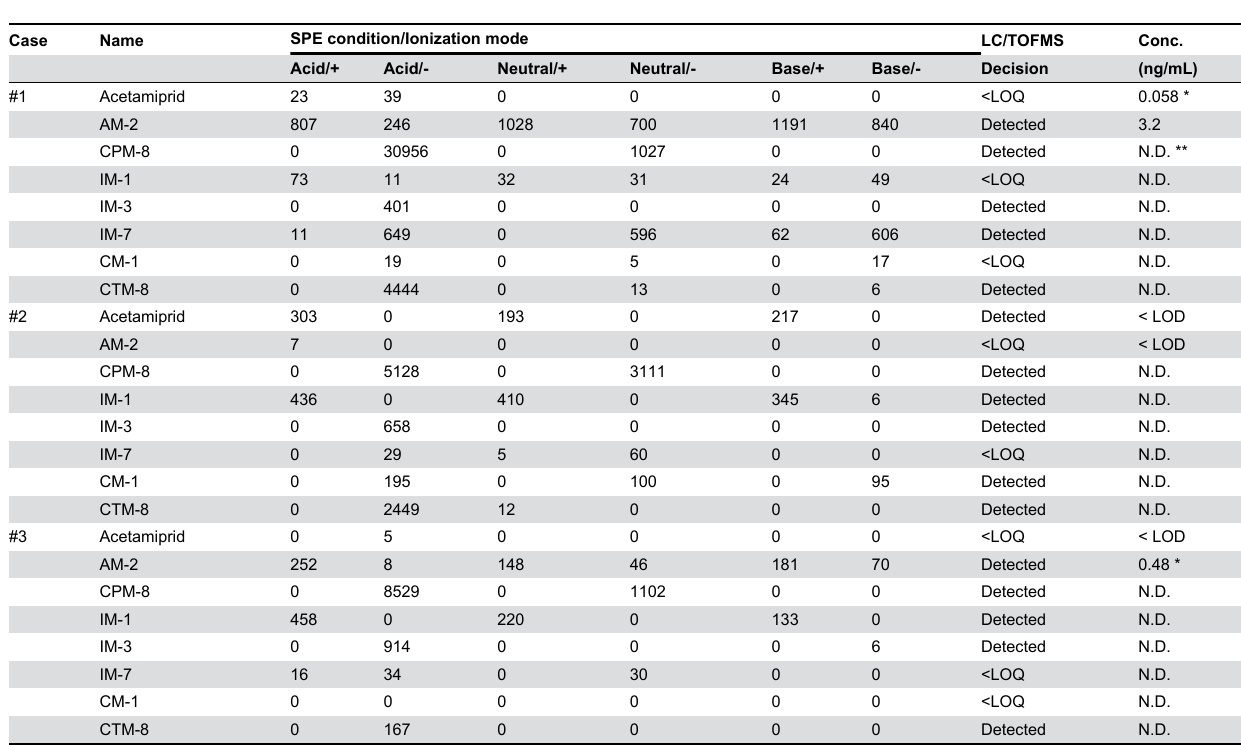
Table 6. Mean intensities of neonicotinoid pesticide metabolites detected by LC/TOFMS and concentrations determined by LC/MS/MS in the urine of three